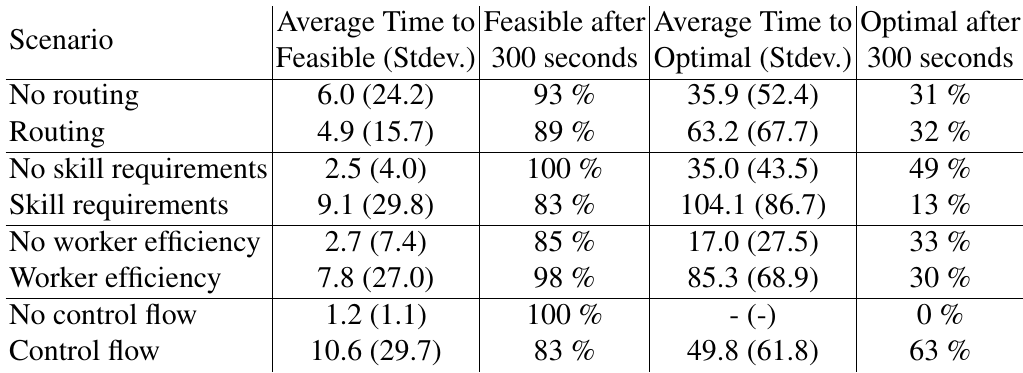
Table 2. The results of the evaluation, with time measured in seconds and also showing the percentage of instances for which a feasible or optimal solution could be found within the time limit. Each scenario consisted of 160 instances, i.e. 20 instances for each of the 8 combinations of the 3 other